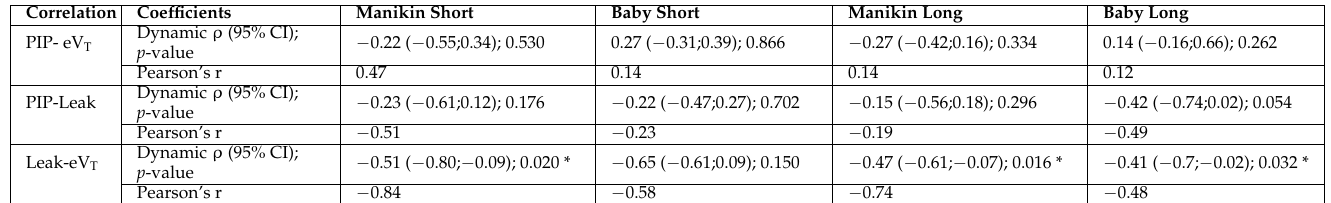
Table 2. Dynamical correlation and Pearson correlation coefficients for pairwise relationships of PIP-eV T -leak for the four groups.